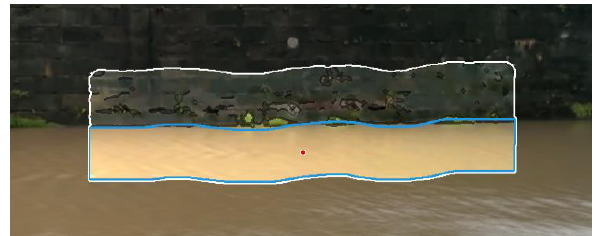
Figure 8. Average image with canny edge map overlay of study region (III); White polygon: ROI from coarse water line preselection; Blue polygon: Initial water body pointing to homogenized dynamic image content; Red: Seed